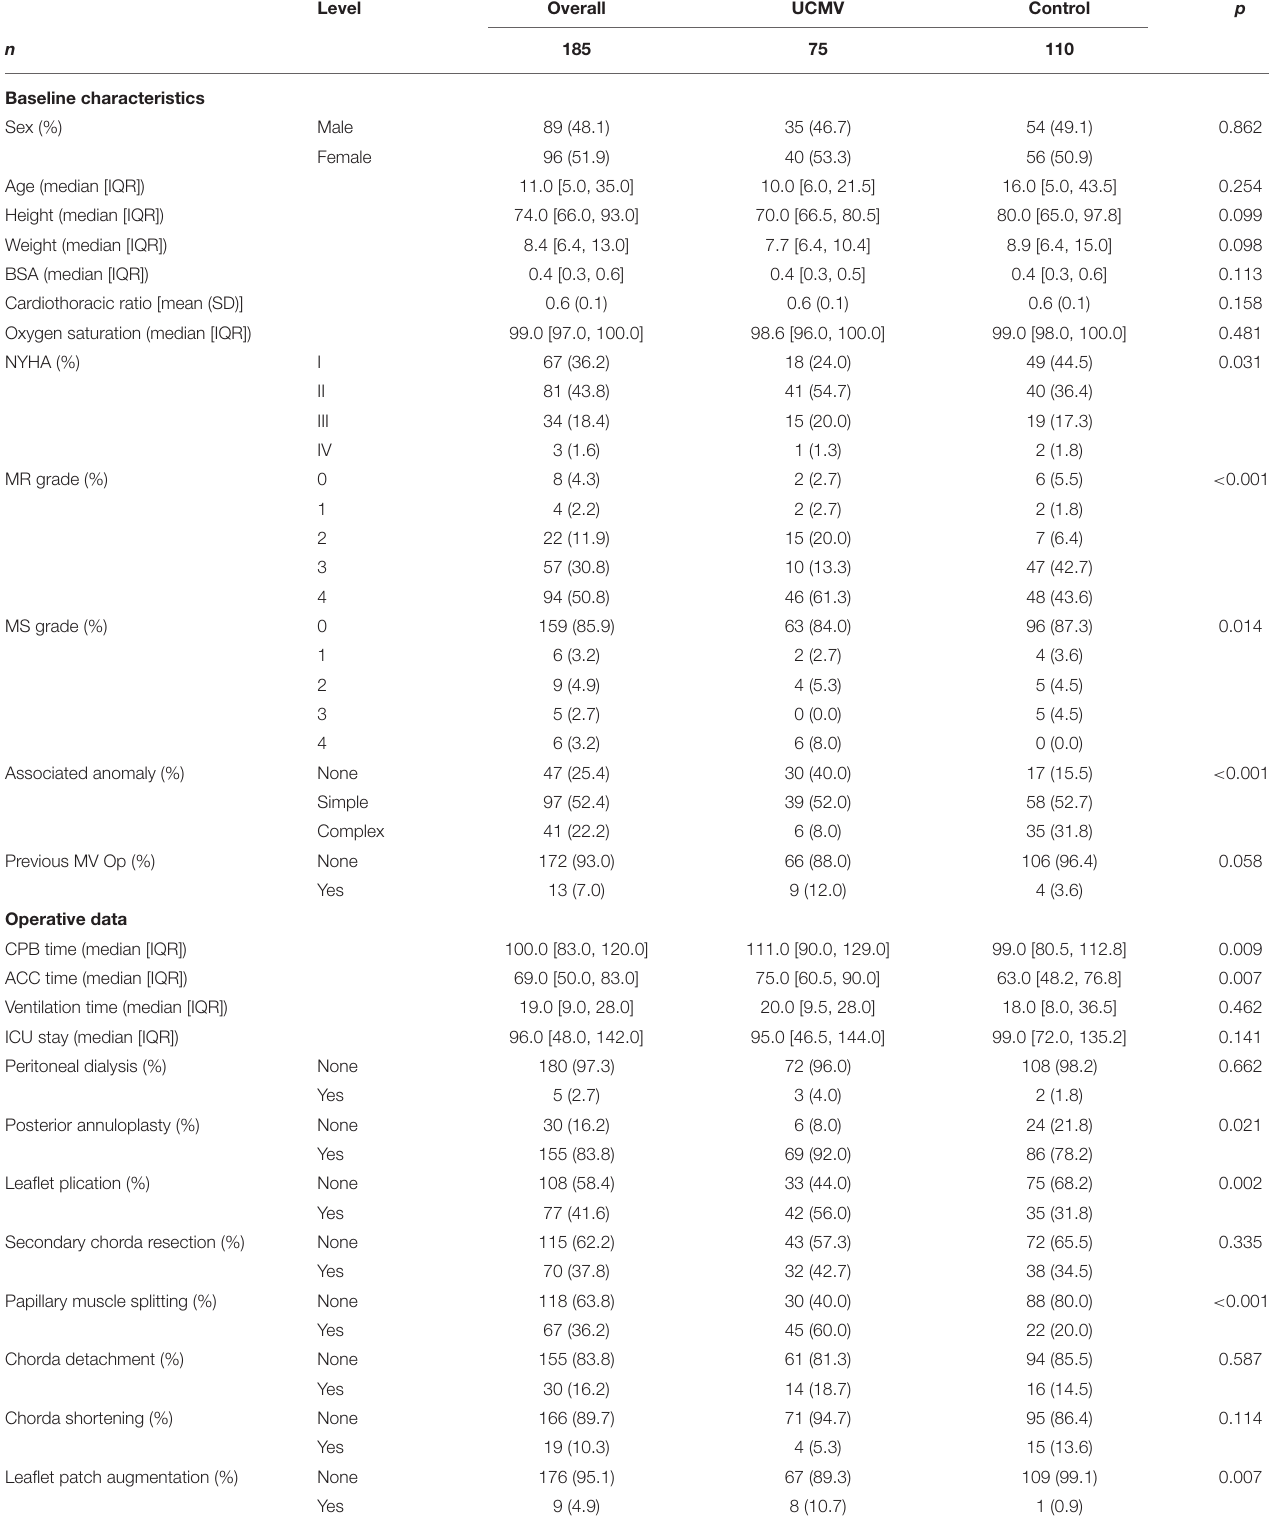
TABLE 1 | Operative patient characteristics. Level Overall